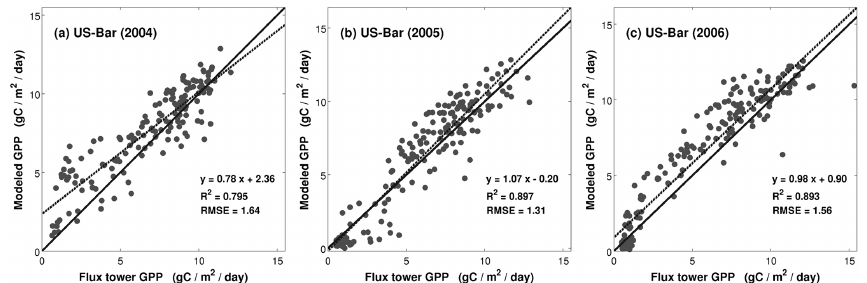
Figure 10. Regressions between modeled and measured daily GPP shown for (a) 2004, (b) 2005, and (c) 2006 at the US-Bar site. Only data during the photosynthetically active period (flux tower GPP >0.5gCm − 2 day − 1 ) are included in the regressions. The solid lines denote the 1 : 1 lines, and the dashed lines denote the regression lines.